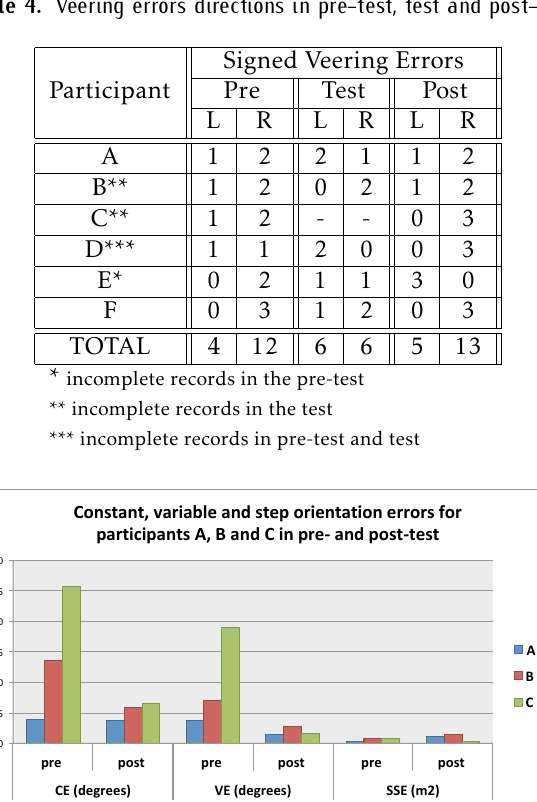
Table 4. Veering errors directions in pre-test, test and post-test